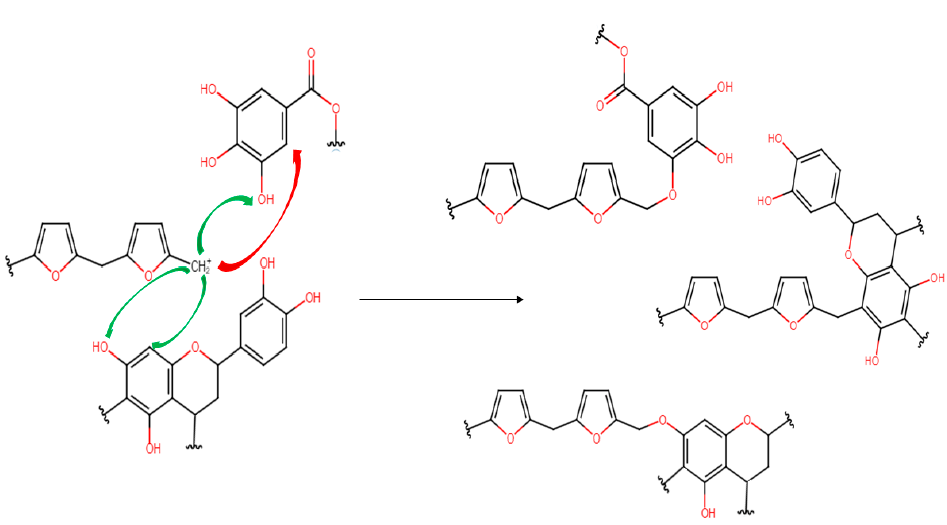
Figure 7. Possible mechanism of non-specific polymerization between polyfurfuryl alcohol and tan-